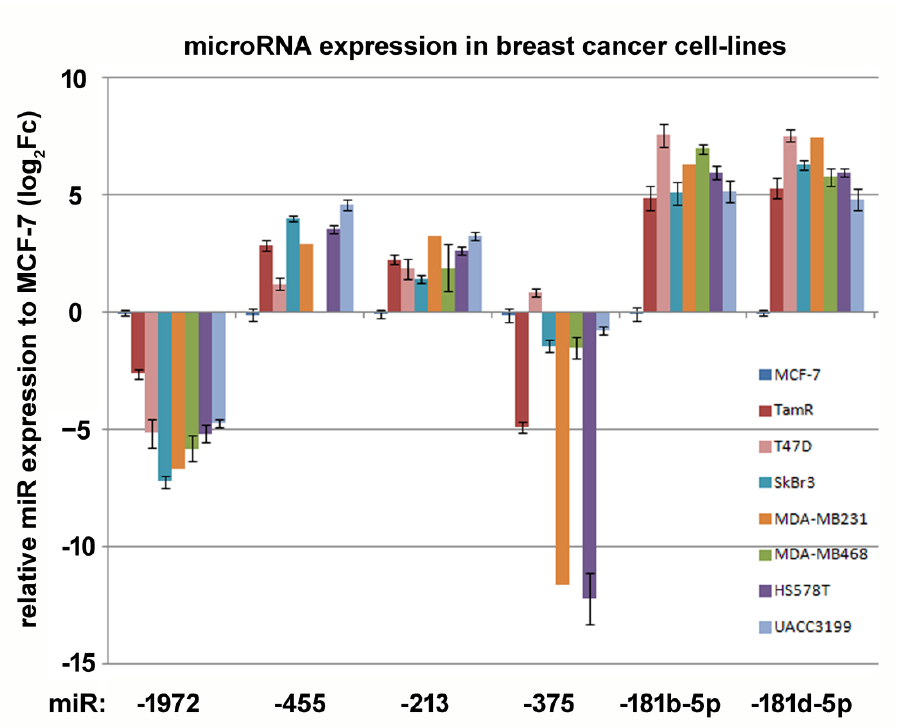
Figure 1. Abundance of tamoxifen-regulated miRNAs in breast cancer cell lines as determined by qRT-PCR, relative to the housekeeping gene rpl-13 . Log 2 of the relative expression towards MCF-7 is shown (log 2 Fc). Error bars indicate standard error (n = 3 – 6). Results of the ANOVA test including post-hoc analysis are presented in Supplemental Table S2.